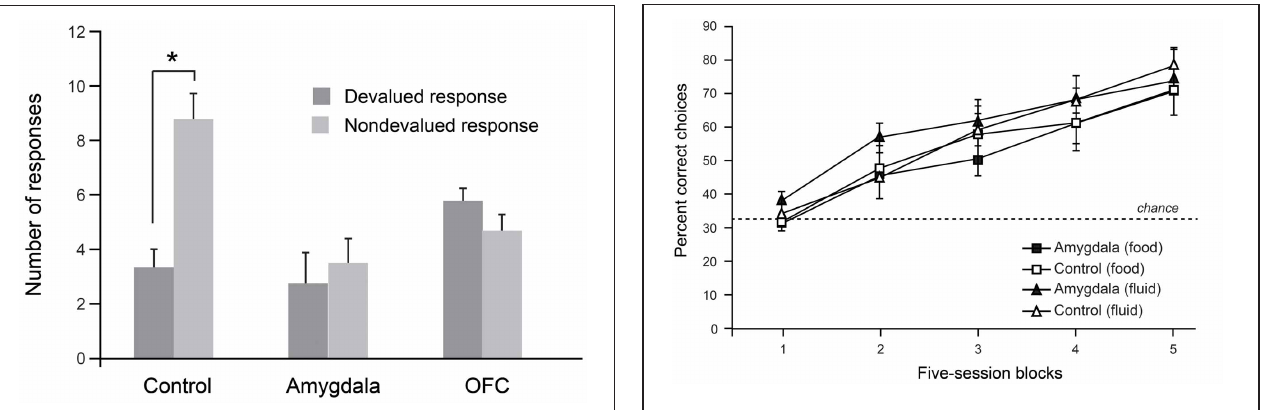
FIGURE 3 | Devaluation effects for action–outcome associations. After selective satiation, unoperated control monkeys perform significantly more of the responses associated with the higher value (non-devalued) food relative to responses associated with the lower value (devalued) food. Thus, controls show classic devaluation effects. Monkeys with either bilateral excitotoxic lesions of the amygdala or bilateral excitotoxic lesions of the OFC fail to show devaluation effects. ∗ p < 0 . 05. Modified from Rhodes and Murray (2013).